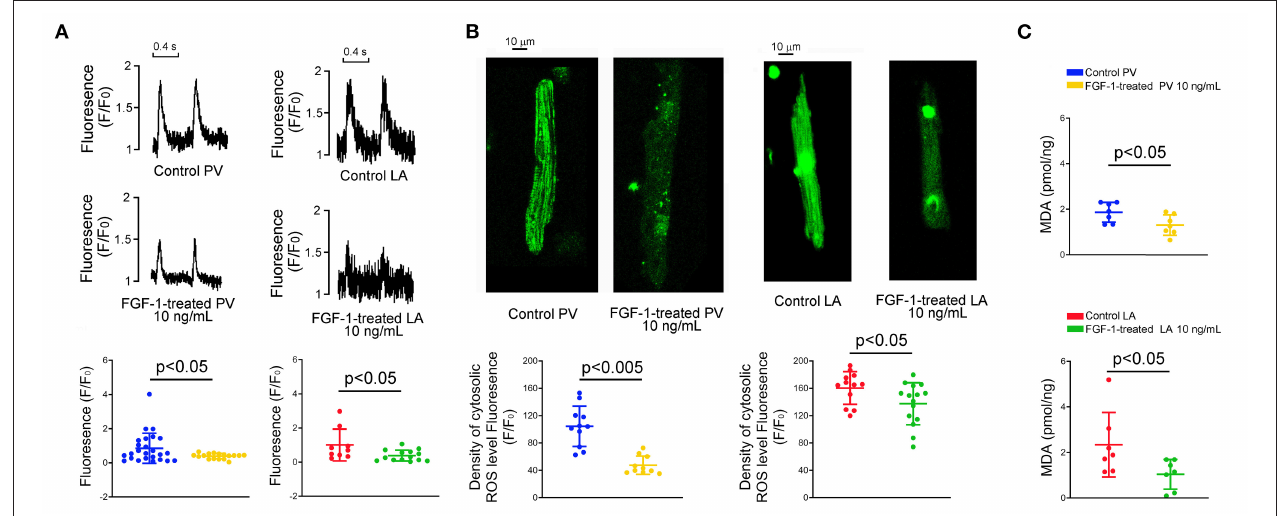
FIGURE 5 | Effect of fibroblast growth factor 1 (FGF1) on intracellular calcium (Ca 2 + ) homeostasis, reactive oxygen species (ROS) and cytosol malondialdehyde (MDA) in pulmonary vein (PV) and left atrium (LA) myocytes. (A) Examples of tracings and scatter plots of Ca 2 + transients in the control and FGF1 (10ng/mL)-treated PV ( N = 25 and 17, respectively), and LA ( N = 9 and 14, respectively), myocytes. (B) Examples and scatter plots of cellular levels of ROS in the control and FGF1 (10ng/mL)-treated PV ( N = 11 and 10, respectively), and LA ( N = 12 and 15, respectively), myocytes. (C) Scatter plots of cytosol MDA in control and FGF1 (10ng/mL)-treated PV (each N = 7) and LA (each N = 7) tissues.